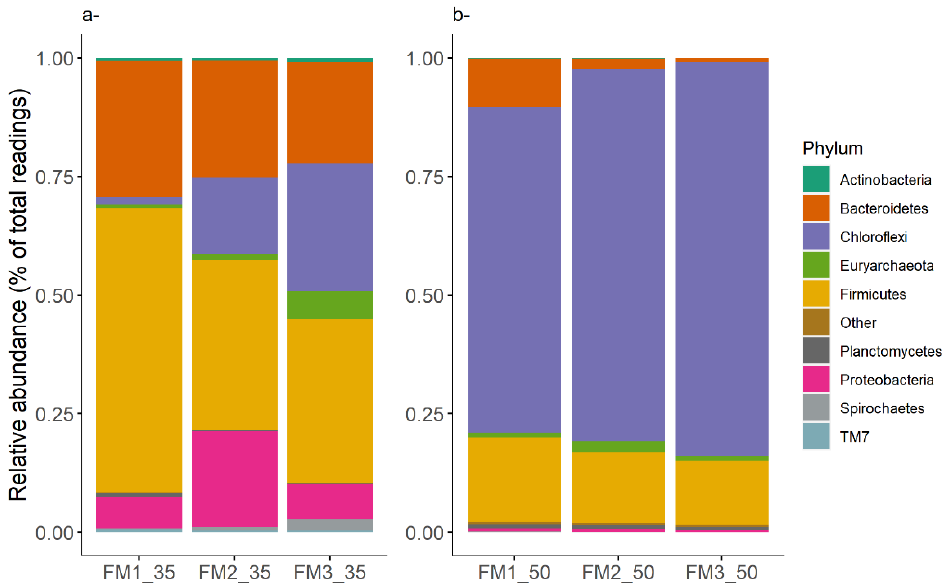
Figure 5. Microbial communities in mesophilic ( a ) and thermophilic ( b ) digesters. Relative abun- dances (% of total readings) of 16S rRNA gene at the phylum level.